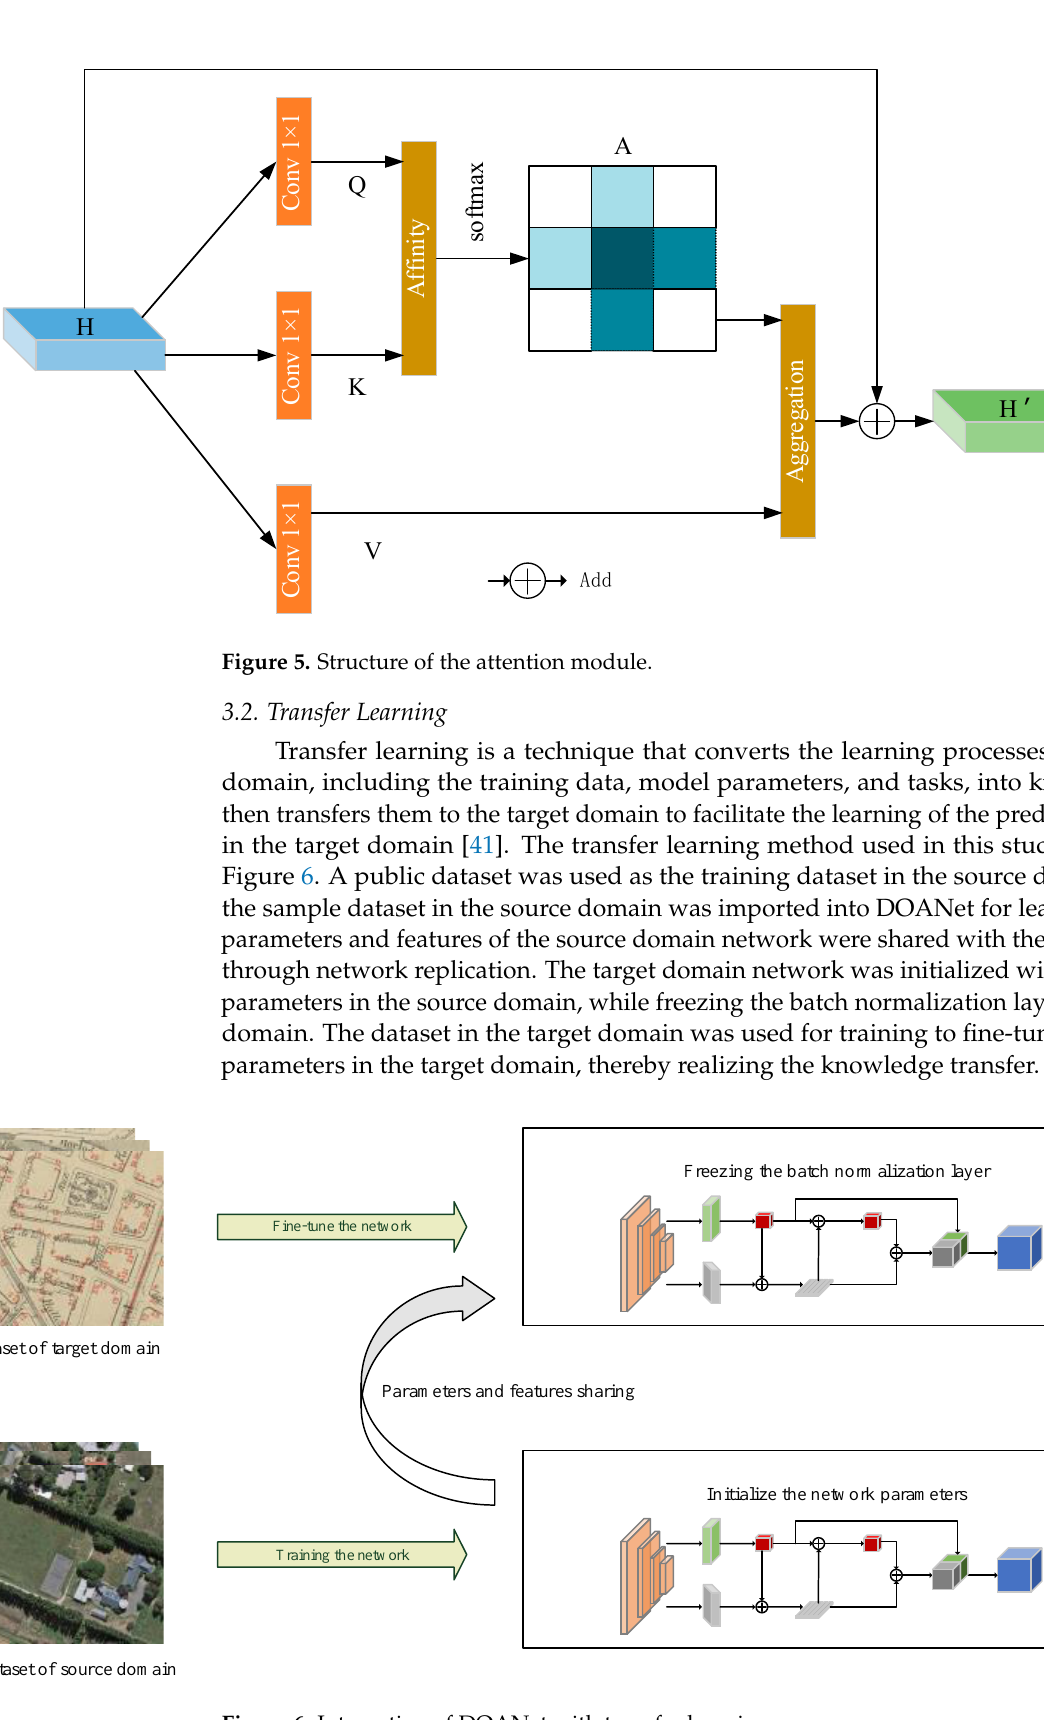
Figure 6. Integration of DOANet with transfer learning.